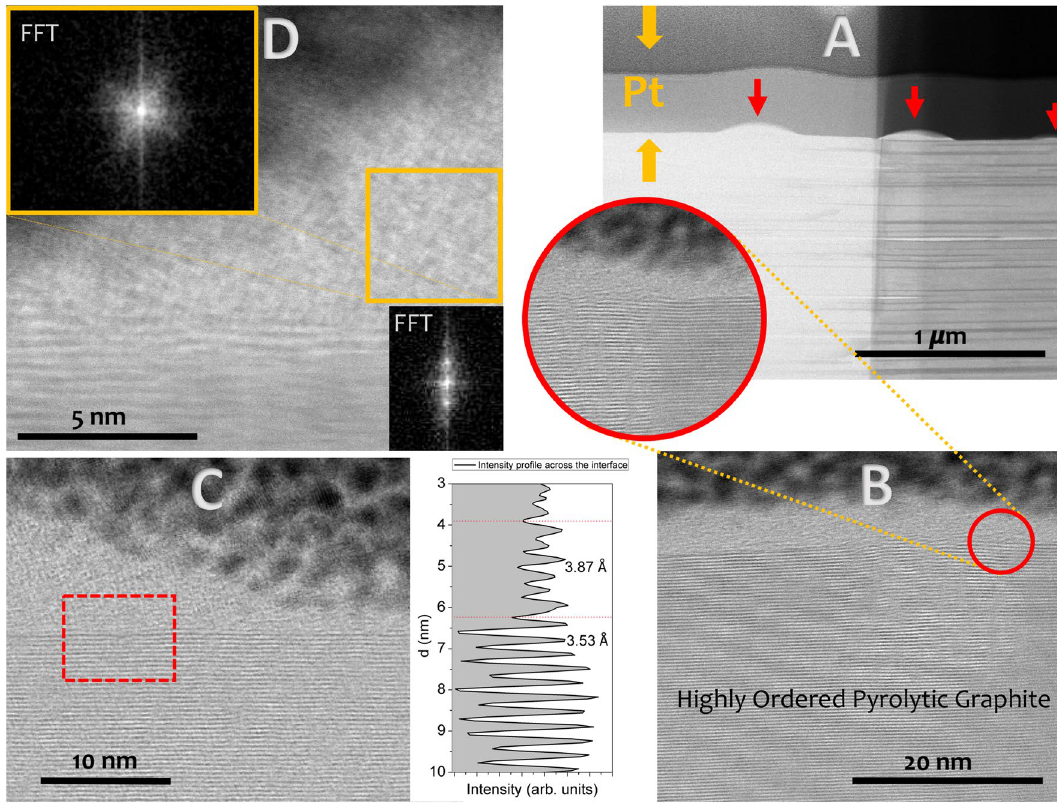
Figure 2. Annular bright field (ABF) images of the irradiated HOPG sample; the magnification of the images increases from ( A ) to ( D ) panels. ( A ) The low magnification image shows bumps or islands of hundreds of nm marked with a red arrow that are formed after UV irradiation of the sample (the change in the contrast is due the thickness gradient of the sample produced during FIB preparation). ( B ) High resolution ABF images show the dislocation of the HOPG layered structure at the irradiated surface (red circle). A cover a few nanometers thick forms between the HOPG and the environment. ( C ) High resolution ABF image of a bump; the separation between the graphene layers is plotted in the bottom right panel. There is a transitional area where separation between the layers increases from 3.53 to 3.87 Å. ( D ) Some apparently cubic structures form within the bump; the FFT shows the marked differences between the HOPG layered structure (bottom right inset) and the rotated patter in the bump (upper left